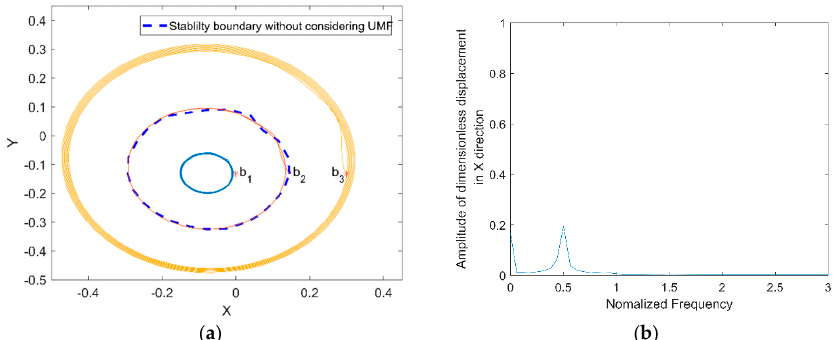
Figure 15. Rotor center trajectory without considering the UMF at F e = 0.0987, M = 0.1403. ( a ) Rotor center trajectory from di ff erent initial positions; ( b ) power spectrum of displacement of the rotor center trajectory starts from b 2 . The red dashed line is the stability boundary with considering UMF at 𝐹 (cid:3032) = 0.0987 , 𝑀 = 0.1403 . The coordinates of three initial positions are 𝑎 (cid:2869) (0.05, − 0.133), 𝑎 (cid:2870) (0.2245, − 0.133) and 𝑎 (cid:2871) (0.4, − 0.133).